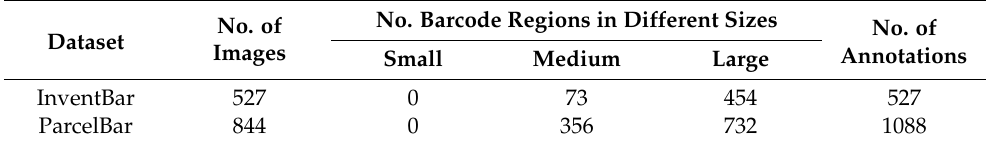
Table 3. Number of different-sized barcode regions contained in InventBar and ParcelBar.